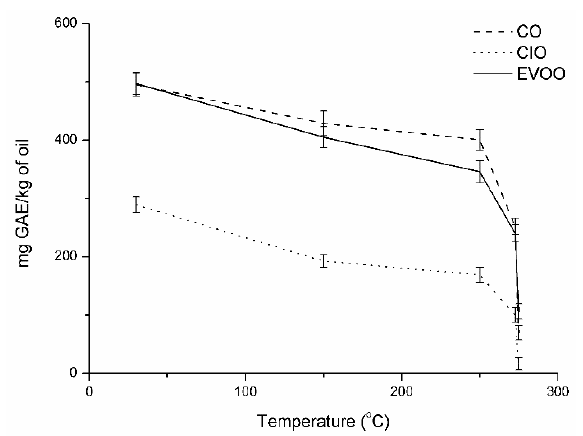
10 of 16 Figure 3. TG curve comparisons for the three different oils showing the selected temperatures corresponding to the degradation of Colliguaya integerrima (CIO), Cynara cardunculus (CO), and extra- virgin olive (EVOO) oils. Figure 3 shows the total phenolic content (TPC) of the different oils at each studied temperature. Analyzing Figure 4, the CO and EVOO oils had the highest TPC at 30 °C (approximately 500 mg/kg), followed by CIO oil with TPC of 289.11 mg/kg. Furthermore, the same behavior was observed when different oils were heated at T int and T 0, showing TPC values of 428.60, 404.98, 192.80, and 400.41, 345.94, and 168.82 mg/kg for CO, EVOO, and CIO oils, respectively. However, if we continued to heat the oils, we found that the TPC was drastically affected, with CIO oil being the most affected, with values of 100.52 and 16.50 mg/kg for T 5% and T 10% , respectively. The TPC value for EVOO oil (106.23 mg/kg) at T 10% was higher than for CO oil (70.00 mg/kg), but is almost negligible. It was thought that this behavior was because the chemical structure of the polyphenols and others minor components presents in the CO oil differed from those present in the EVOO oil, which are hydroxytyrosol, tyrosol, and their derivatives (secoiridoids) [43]. Apart from phenols and secoiridoids, triterpenes, such as maslinic and oleanolic acid, the existence of other minor components has been widely documented,